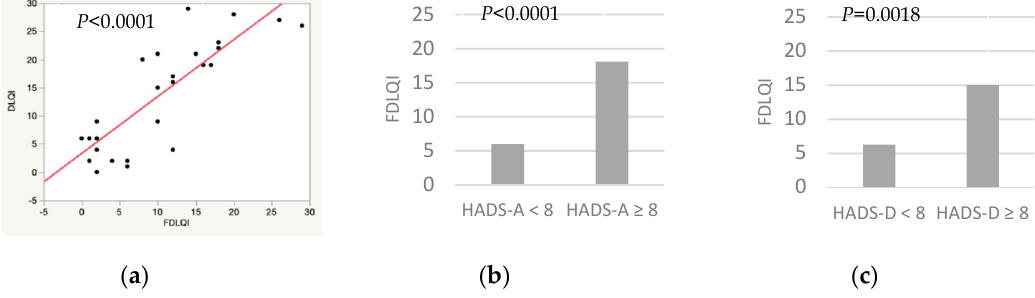
Figure 3. Potential factors associated with worse quality of life in cohabitants of patients with hidradenitis suppurativa. ( a ) Simple linear regression. Dermatology Life Quality Index (DLQI) / Familiar Dermatology Life Quality Index (FDLQI). ( b ) χ 2 test. Cohabitants’ anxiety (Hospital Anxiety and Depression Scale, anxiety subscale (HADS-A) ≥ 8) / FDLQI. ( c) χ 2 test. Patients’ depression (Hospital Anxiety and Depression Scale, depression subscale (HADS-D) ≥ 8) / FDLQI.